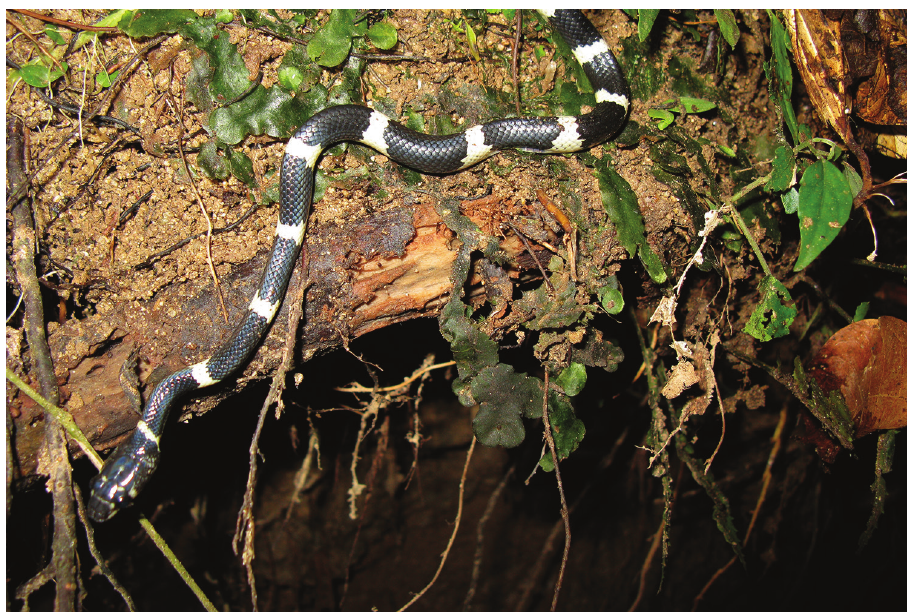
Figure 69. Lycodon dumerilii (KU 319989) from Mt. Magdiwata, Barangay Bagusan II, Municipality